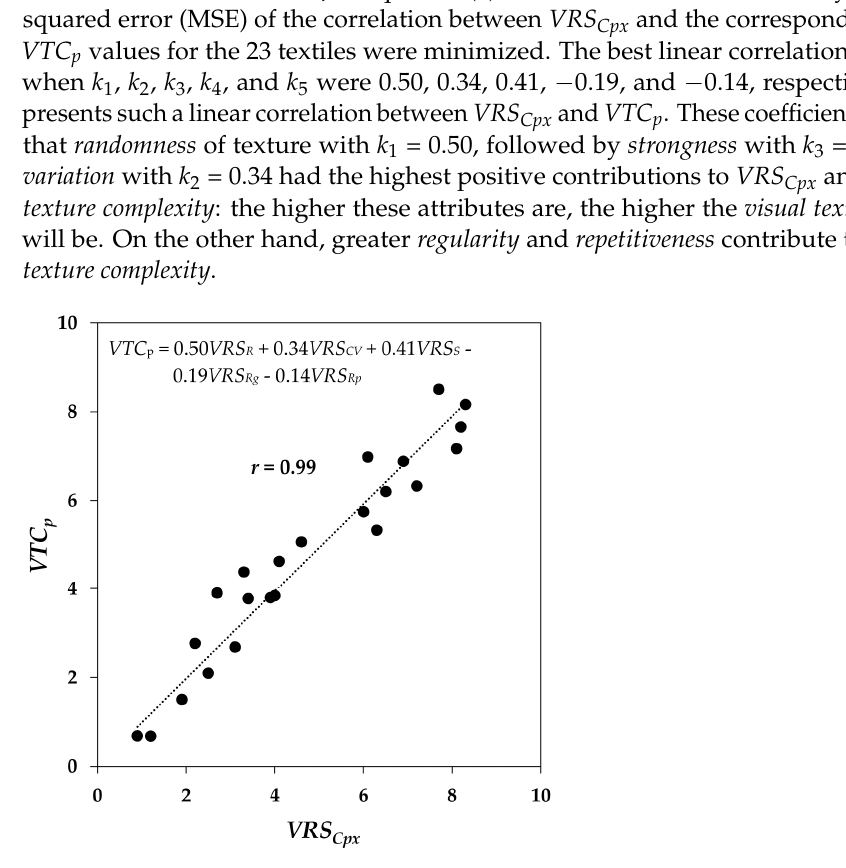
Figure 9. The correlation between VRS Cpx and VTC p . VTC p in Equation (2) is an intermediate variable defined to hold the ‘predicted’ visual texture complexity computed as the weighted sum of VRS R , VRS CV , VRS S , VRS Rg , and VRS Rp to have the best linear correlation with VRS Cpx .